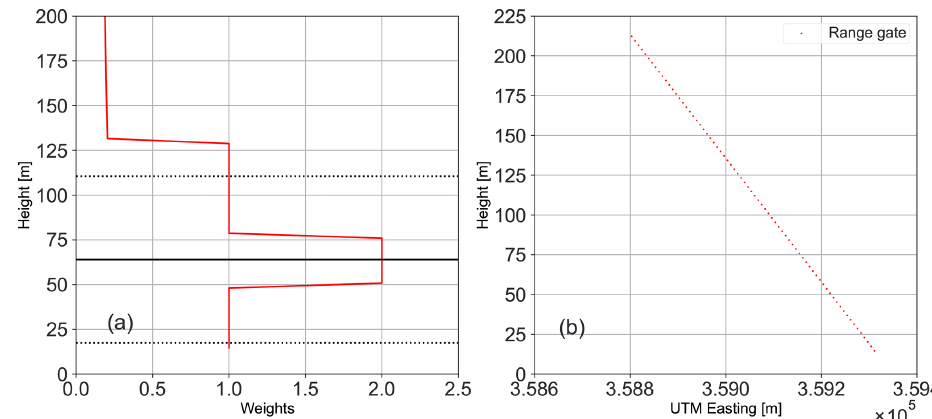
Figure 8. (a) Height varying weights used for the distance metrics in the minimization problem. (b) Locations of 72 range gates, with range gate 1 being the lowest and closest to the turbine B08 and 72 being the highest and furthest away.